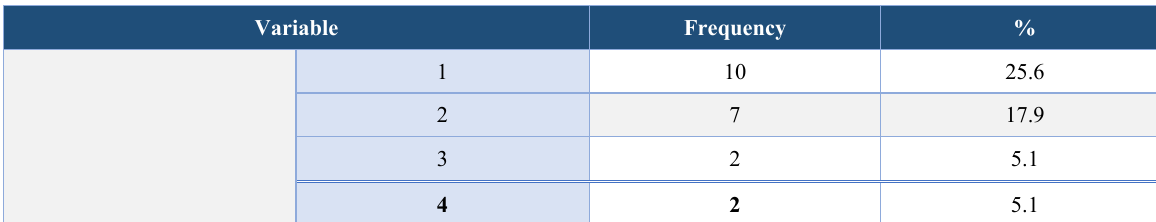
Table 4 . Determination and comparison of intensity and percentage of staining in three groups Normal Pre-cancerous Cancerous N Row% Column% N Row% Column% N Row% Column%